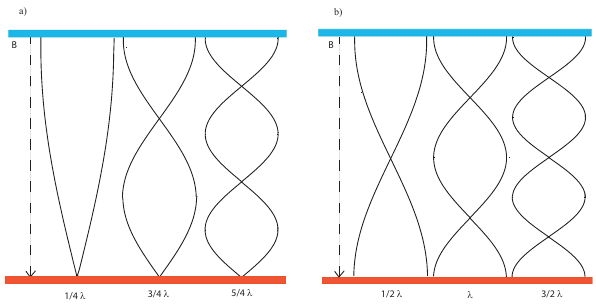
Figure 10. In both panels the lower red rectangle represents the lower IAR boundary and the blue rectangle represents the upper IAR boundary. The background magnetic field is directed downwards for high latitude northern hemisphere regions. Panel a) shows the perpendicular electric field for the first 3 eigenmodes for the case of a high conductivity ionosphere with a node at the lower IAR boundary. Panel b) shows the first 3 standing wave modes in the case of a low conductivity ionosphere with an antinode at the lower IAR boundary.